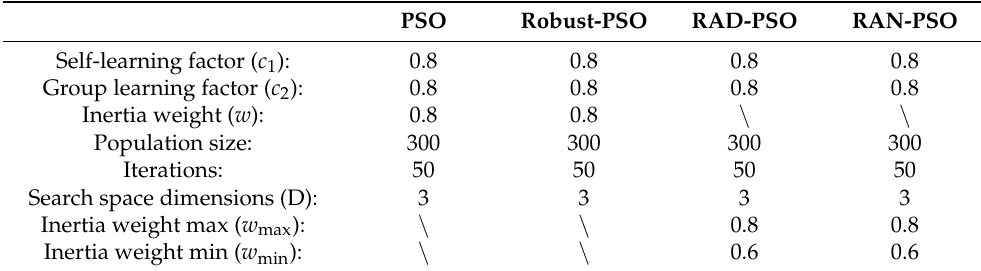
Table 2. Robust model parameter